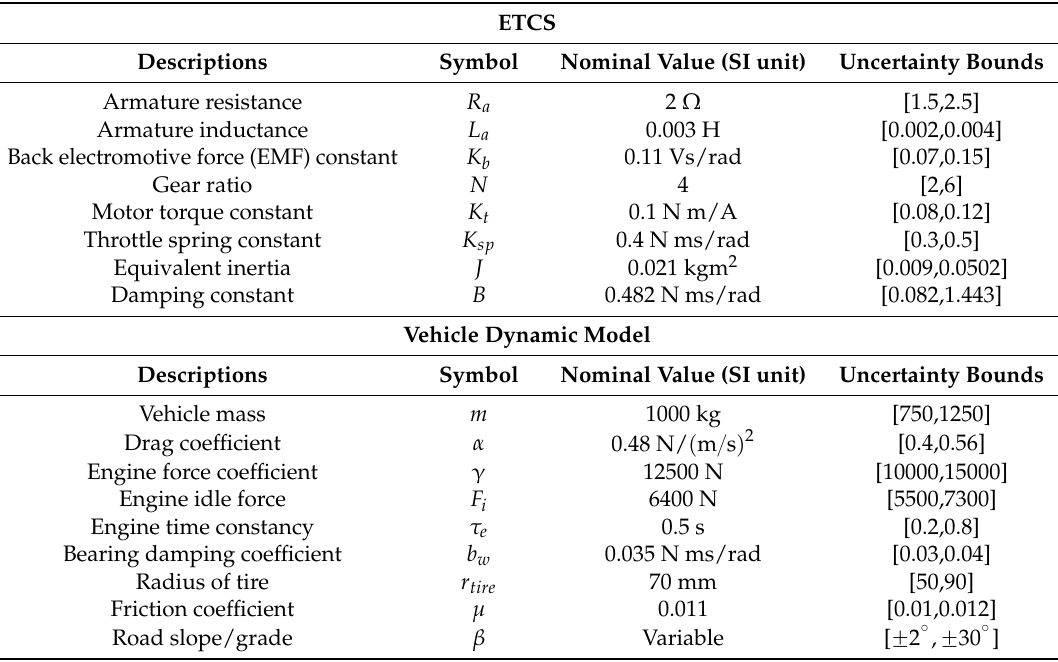
Figure 1. The speed control scheme of the HEV with an electronic throttle control system (ETCS) and a nonlinear vehicle dynamic system. Table 1. The nominal values and uncertainty parameters of the HEV.